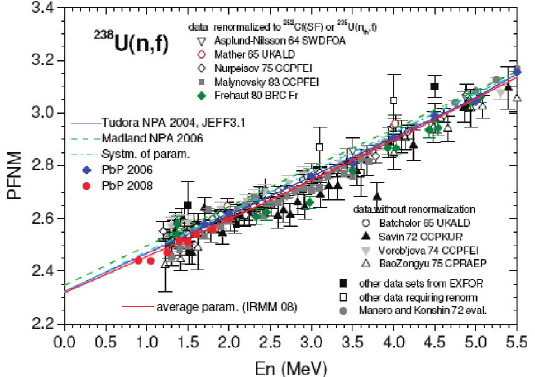
Fig. 4. The PbP multiplicity calculations (red full points) compared to previous results and experimental data.